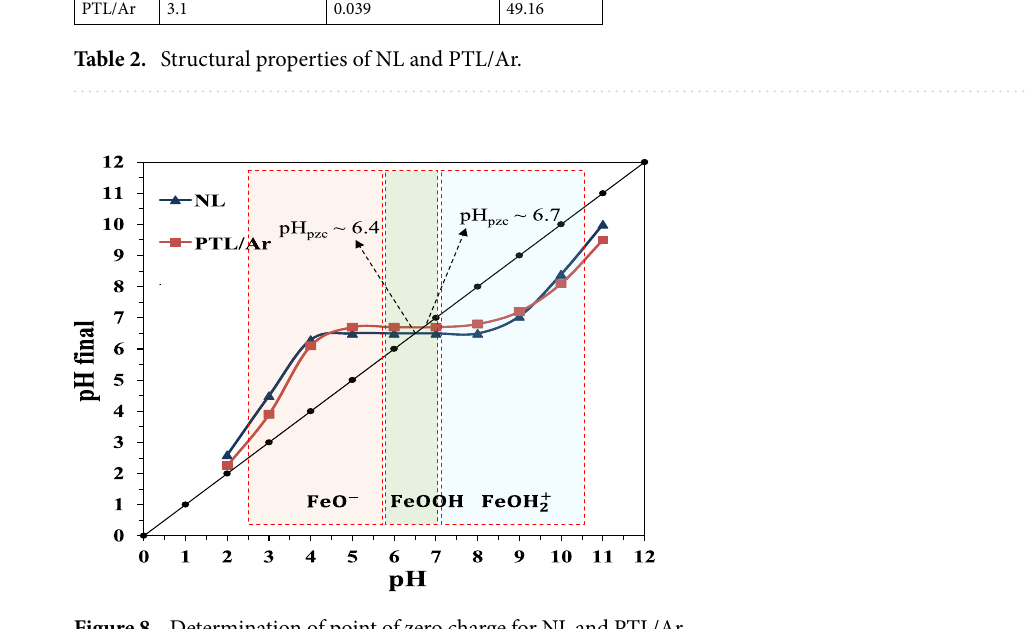
Figure 8. Determination of point of zero charge for NL and